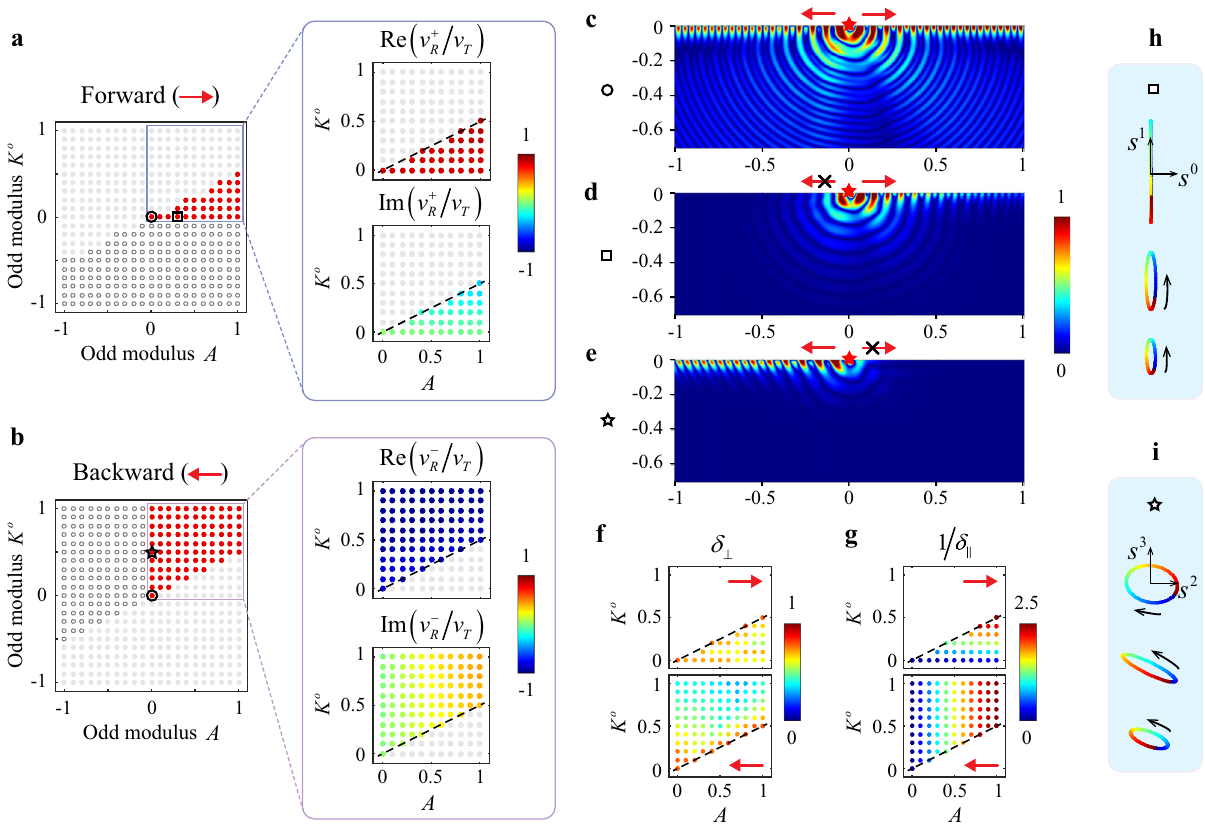
for the forward propagating Fig. 3 Non-Hermitian Rayleigh waves in half-space. a Scatter plots showing the phase diagram and the complex velocity v þ R Rayleigh waves, and b corresponding to v (cid:2) in the backward direction. Beyond the stable solutions (red dots), we use gray dots and hollow circles to R differentiate between no solution and instability, respectively. The red arrows indicate either a forward or backward propagating direction. The dashed lines mark the transition of one-way propagation reversal. c – e Numerically calculated modal fi elds with parameters highlighted in ( a , b ). In each simulation, a vibrating source (red stars, ω = 15 π ) is placed on the top surface to excite surface waves, and the modal fi elds are normalized with regard to their own maximum values. f , g Scatter maps rendering the penetration depth δ ⊥ and the reciprocal propagation length 1/ δ ∥ (normalized to the wavelength) for the non-Hermitian Rayleigh waves. In here, we discriminate between forward and backward propagating waves. h A group of odd-elastic engine cycles at different depths for the Rayleigh waves studied in d . i Likewise for the scenario illustrated in e . In this study, we set material parameters μ = 0.5 and α =